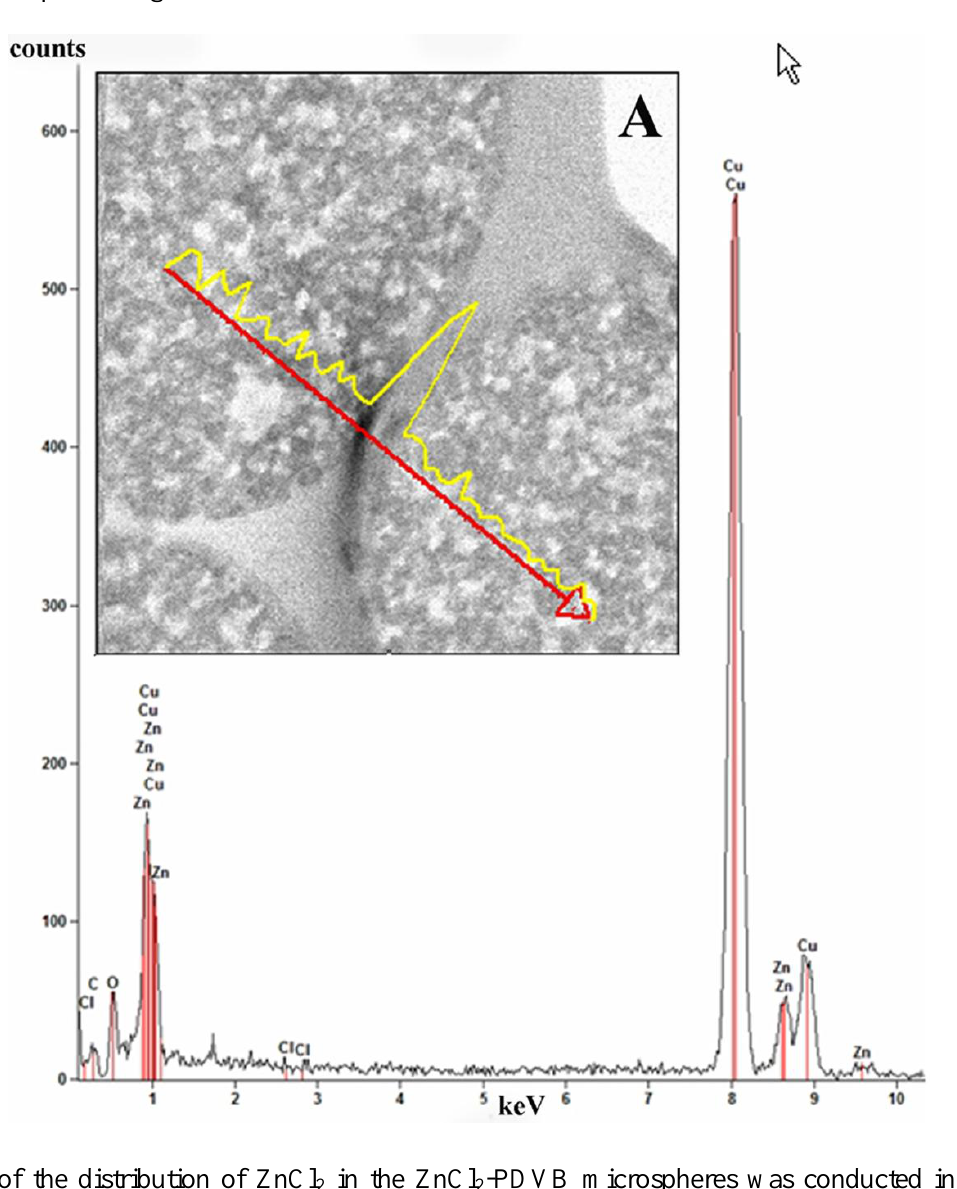
Figure 9. Bright field scanning transmission electron mode (STEM) image of ZnCl -PDVB microspheres. Elemental line scan is shown for Zn (inset A ). The red arrow 2 marks a line on the surface of the microspheres where the line scan was performed. The figure shows the EDS spectrum recorded from a 35 nm area of a microsphere showing characteristic peaks of the elements C, O, Cl and Zn in the analyzed area. The Cu peak is from the specimen